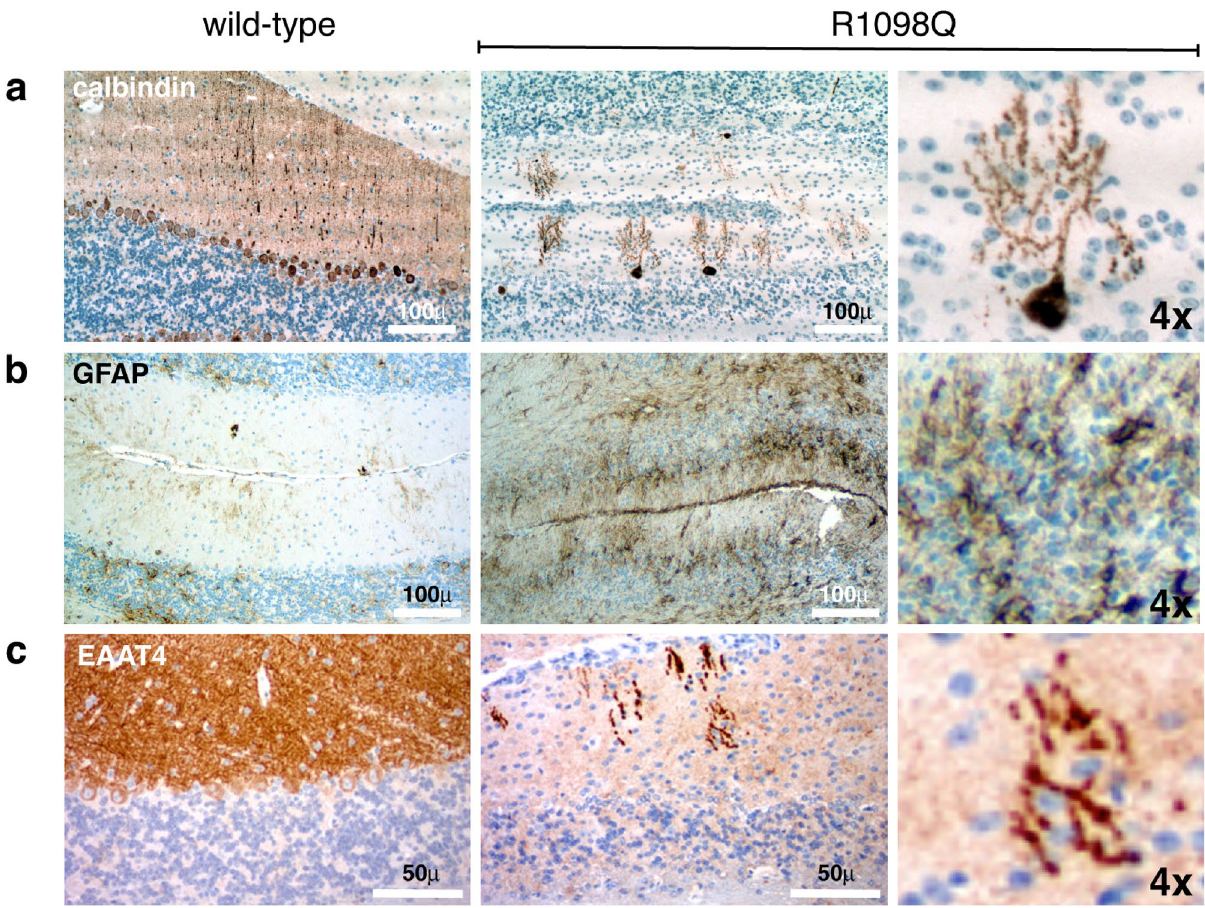
Figure 4. Evidence of cerebellar degeneration and gliosis. We used immunostains with markers of degeneration, reactive gliosis, and synaptic integrity to further characterize the cerebellar changes in 1.5 yo R1098Q heterozygous mice. Images in the right-most panel of each row are presented at 4 × magnification relative to the other images. ( a ) Calbindin, a marker of PCs, highlights their dramatic loss and their excessively branched, segmented, and coarse dendrites. ( b ) Glial fibrillary acidic protein (GFAP), a marker of reactive gliosis and an indirect marker of neuroinflammation, reveals a marked increase in both the molecular and granular cell layers. Astrocytes and their processes infiltrate all cerebellar layers. ( c ) EAAT4, a glutamate transporter that binds spectrin at Purkinje cell PSDs, is nearly absent in the R1098Q mice, and what remains is concentrated in the swollen dendritic shafts of